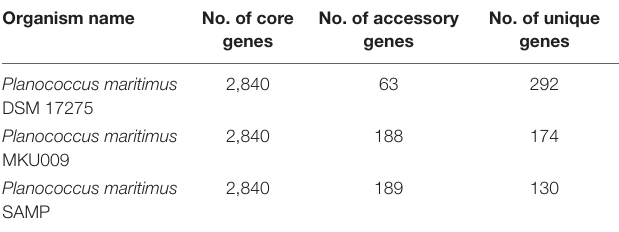
TABLE 2 | Showing the number of core, accessory and unique genes within the